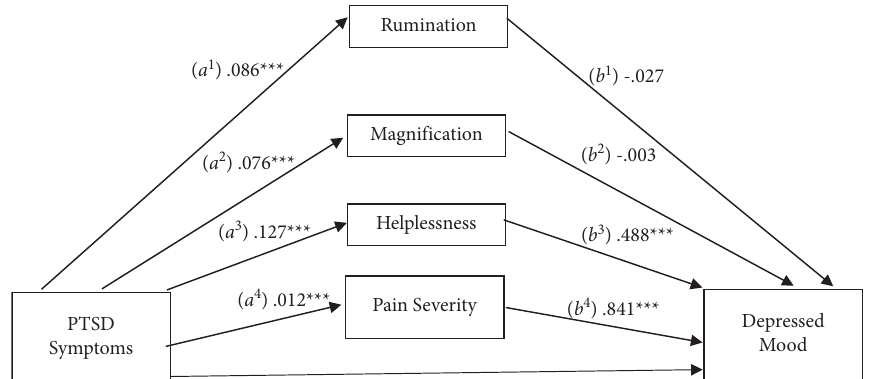
Figure 5: Mediation of the relationship between PTSD symptomatology and pain severity by pain catastrophizing subscales and depressed